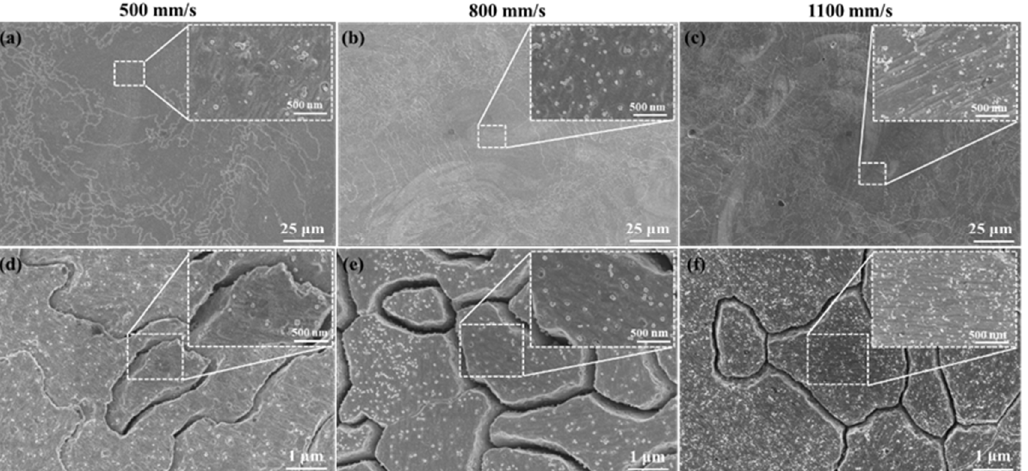
Figure 12. The second phases on the XY planes of Cu–Cr–Nb–Ti alloy samples manufactured at di ff erent scanning speeds using laser power of 325 W (the upper-right corner shows enlarged images): ( a – c ) the second phases in the coarse grains in the samples P 325 V 500 , P 325 V 800 , and P 325 V 1100 manufactured by 500 mm/s, 800 mm/s, and 1100 mm/s, respectively; ( d – f ) are the second phases in the fi ne grains in samples.